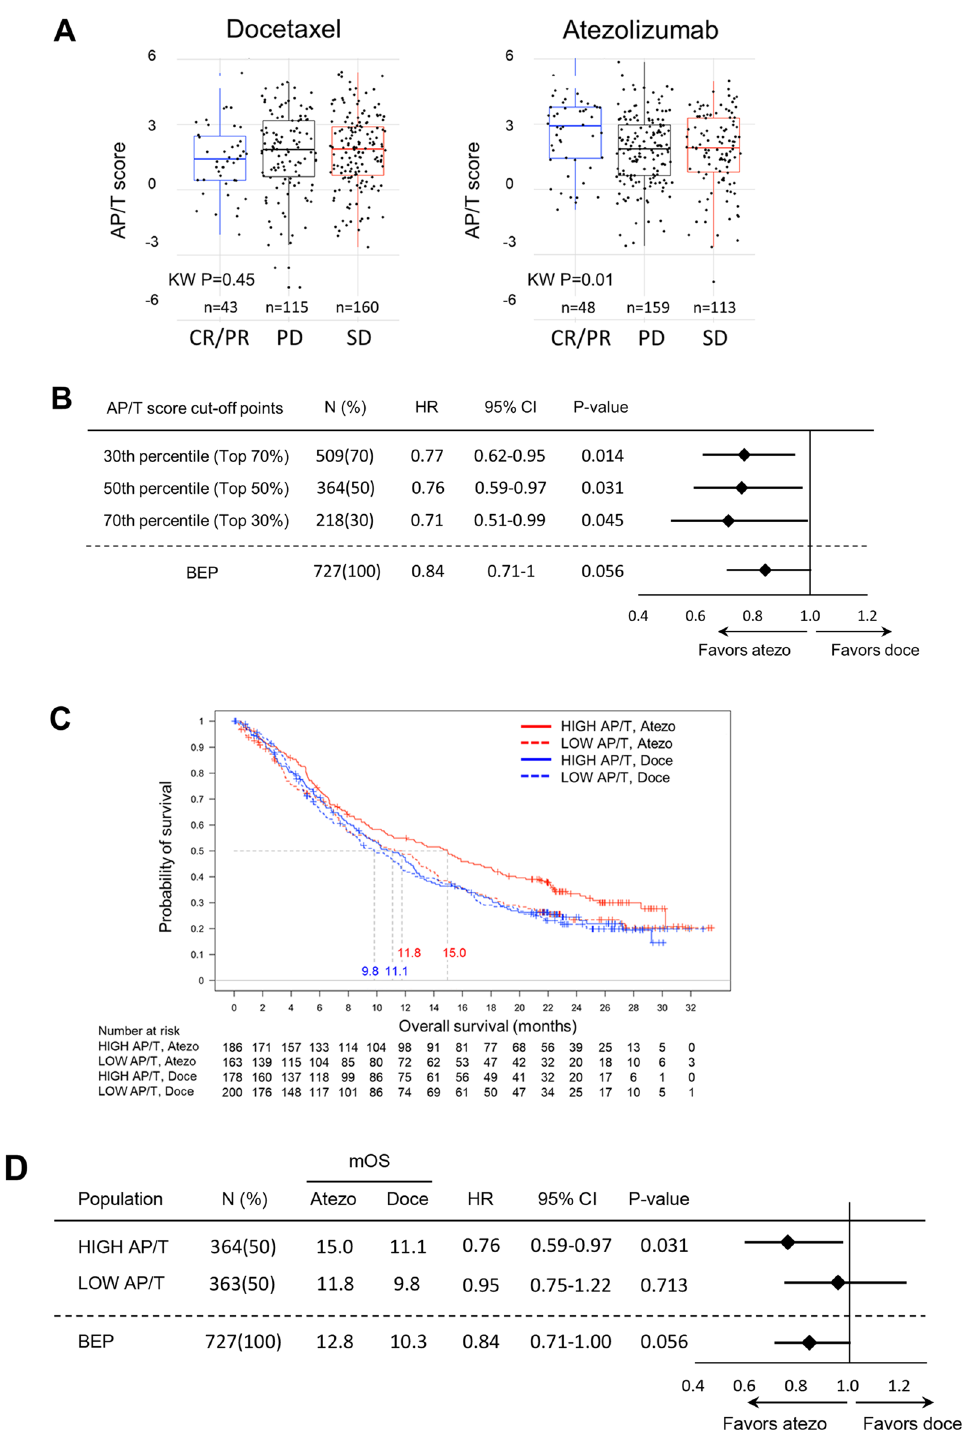
Figure 7. Association of clinical outcome and expression of antigen-presenting DC-related gene and CXCR3 ligands genes in tumor tissue in the phase 3 OAK trial. ( A ) Relation between overall response rate and AP/T score. ( B ) Forest plots of hazard ratios (HR) for OS in the biomarker-evaluable population (BEP) and in subgroups with AP/T scores above the 30th, 50th, and 70th percentile cut-off points (top 70%, 50%, and 30% of the population, respectively). ( C , D ) Kaplan–Meier estimates and forest plots of HRs for OS in the HIGH and LOW AP/T subgroups (cut at 50th percentile) in the atezolizumab and docetaxel treatment